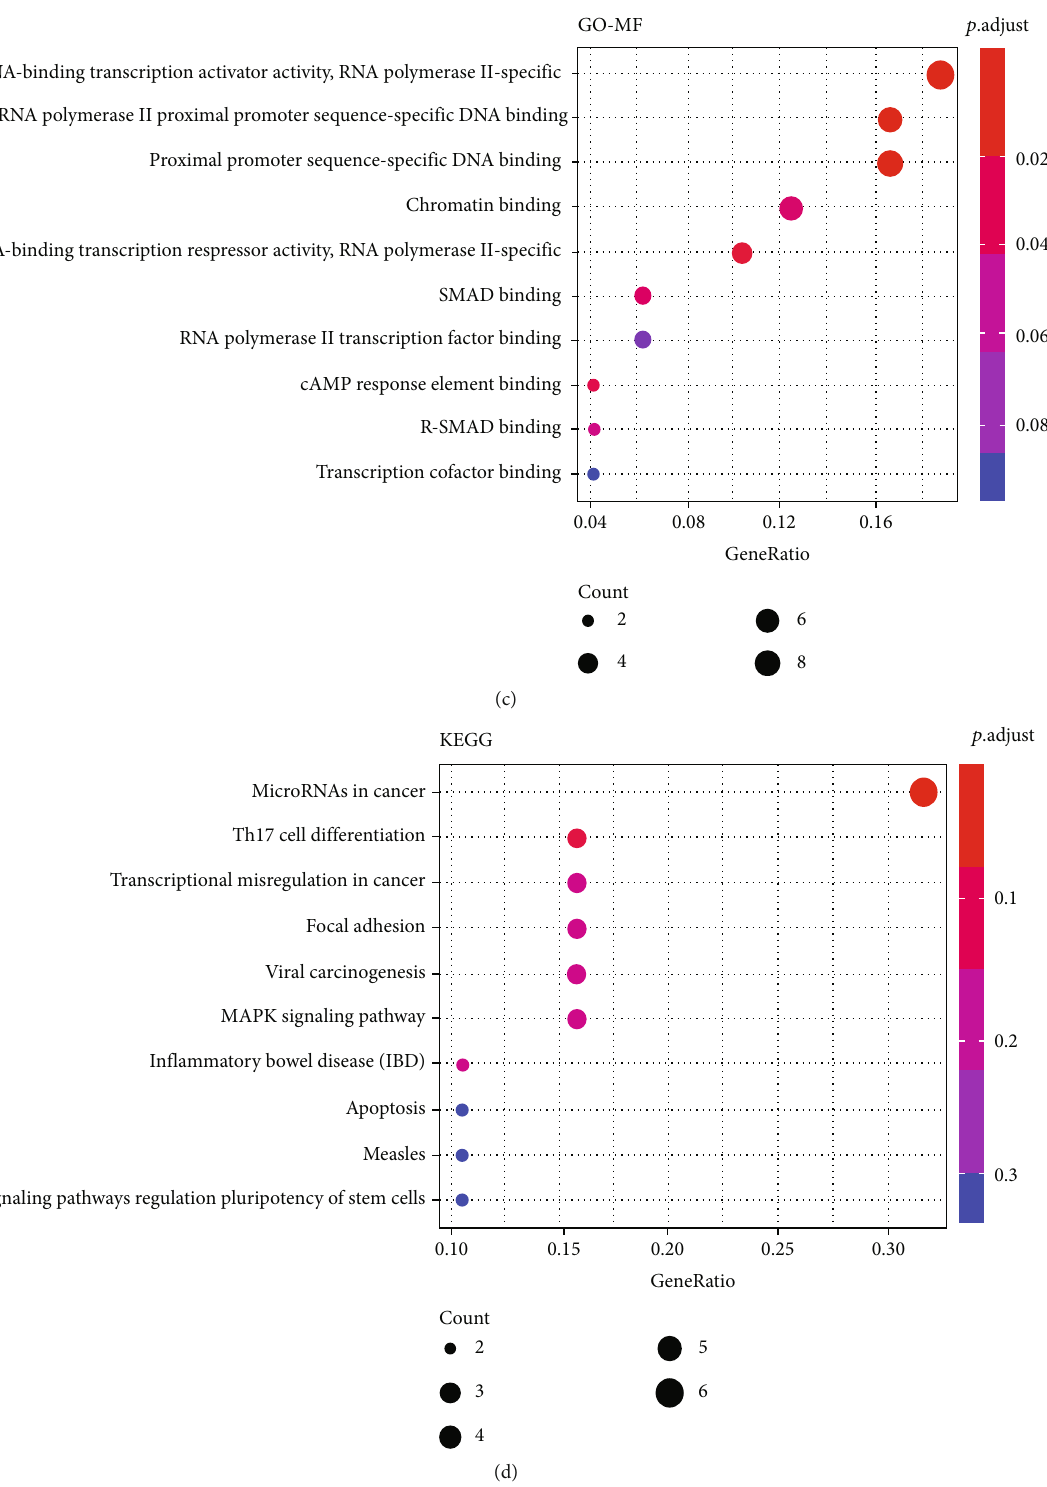
Figure 4: Functional enrichment analysis of the targeted mRNAs by GO and KEGG pathway analysis. (a) Results of the targeted mRNAs that were enriched in the biological process by GO analysis. (b) Results of the targeted mRNAs that were enriched in the cellular component by GO analysis. (c) Results of the targeted mRNAs that were enriched in the molecular function by GO analysis. (d) Results of the targeted mRNAs that were enriched in the metabolic pathway by KEGG pathway